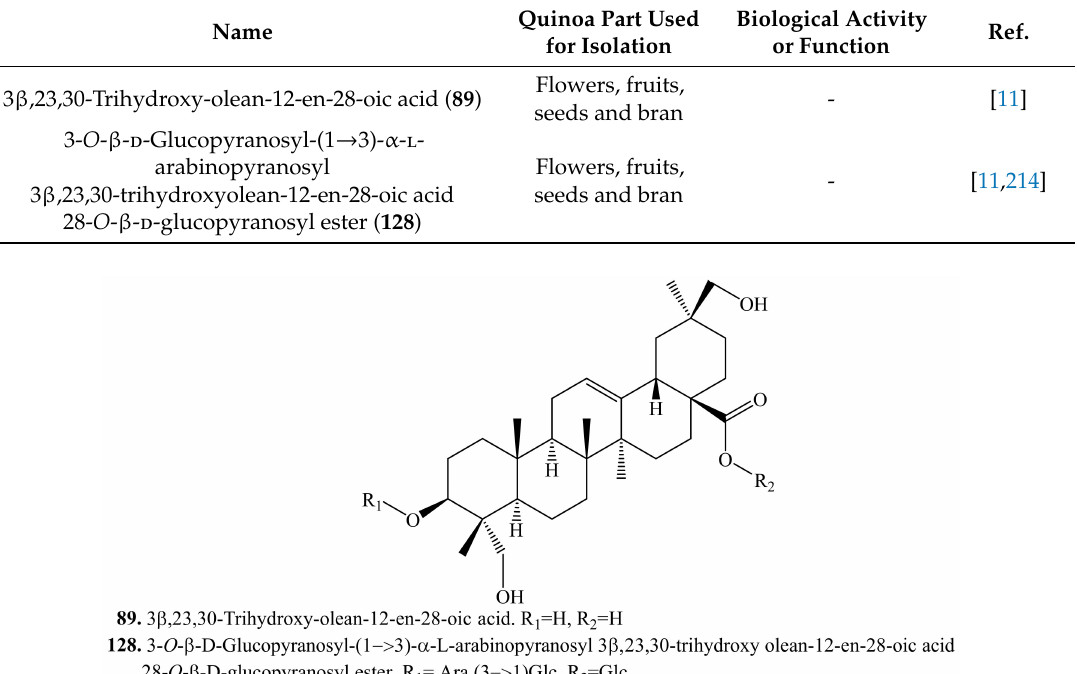
Figure 18. Structures of the 3 β ,23,30-trihydroxy-olean-12-en-28-oic acid triterpenoids isolated from quinoa.